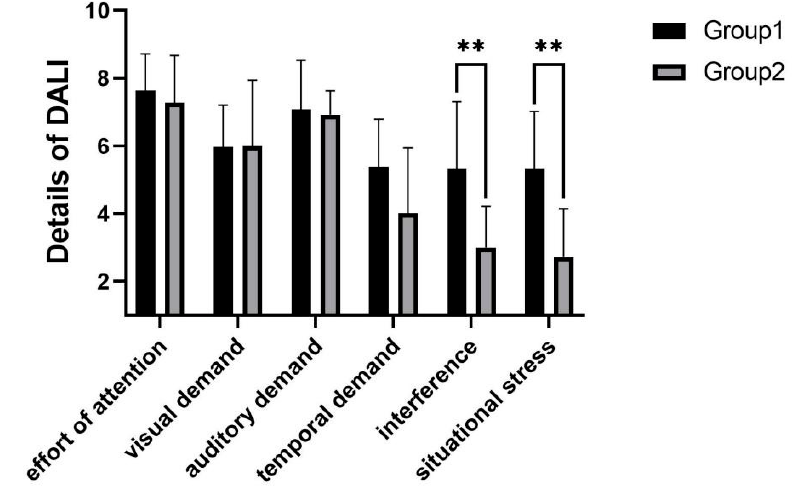
Figure 11. Workload in telephone task. ** indicates significant difference ( p < 0.01).